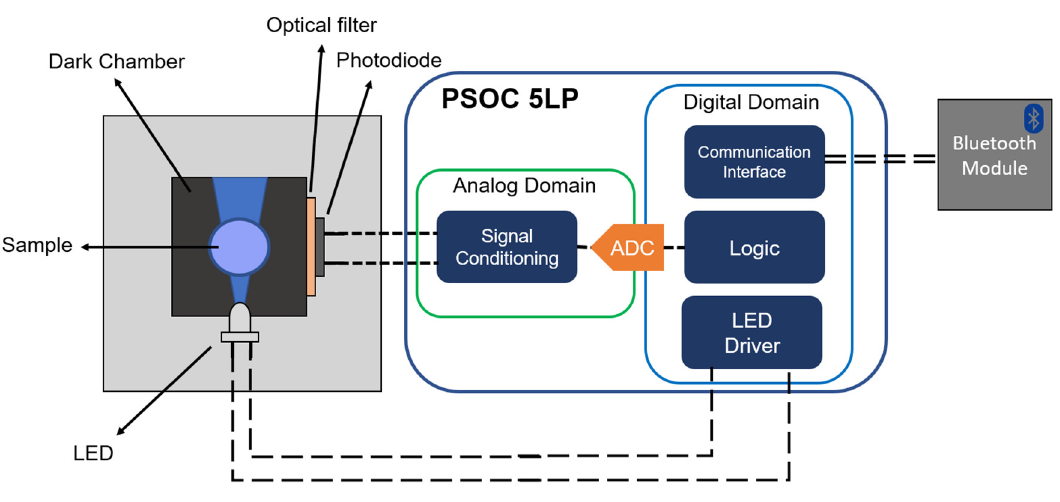
Figure 1. Block diagram of the developed device showing the electronics module and the measurement setup .